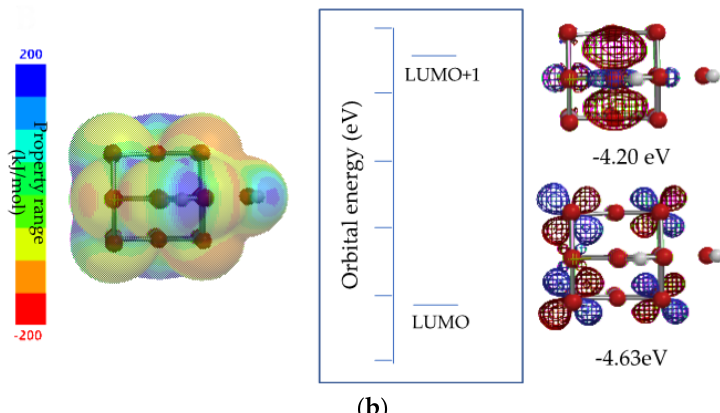
Figure 6. Electrostatic potential map and electron energy structure of TiO 2 anatase model of Ti 9 O 18 H and OH: ( a ) side view; ( b ) view from top.